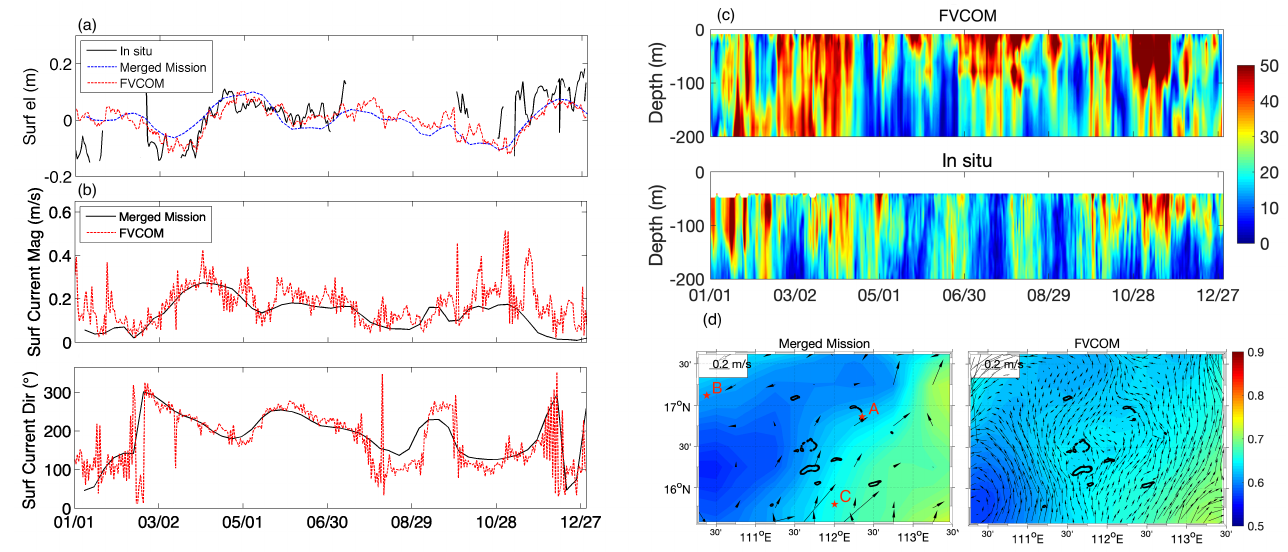
Figure 2. Comparison of the modeled time sequences for: (a) surface elevations at point A, (b) the XA regional mean current, and (c) velocity magnitudes (in cm/s) at point B against in situ monitoring data and/or AVISO data during 2009; and (d) modeled annual averaged surface elevation (in m) and geographic current (at a depth of 15 m) against AVISO in 2009. An annual mean northeastward geographic current can be observed in the XA. Points A and B are the tidal gauge station located at 16.84 ◦ N, 112.33 ◦ E and Xisha subsurface buoy located at 17.10 ◦ N, 110.39 ◦ E, respectively. Point C is an upper layer velocity observation point, as mentioned in Section 4.